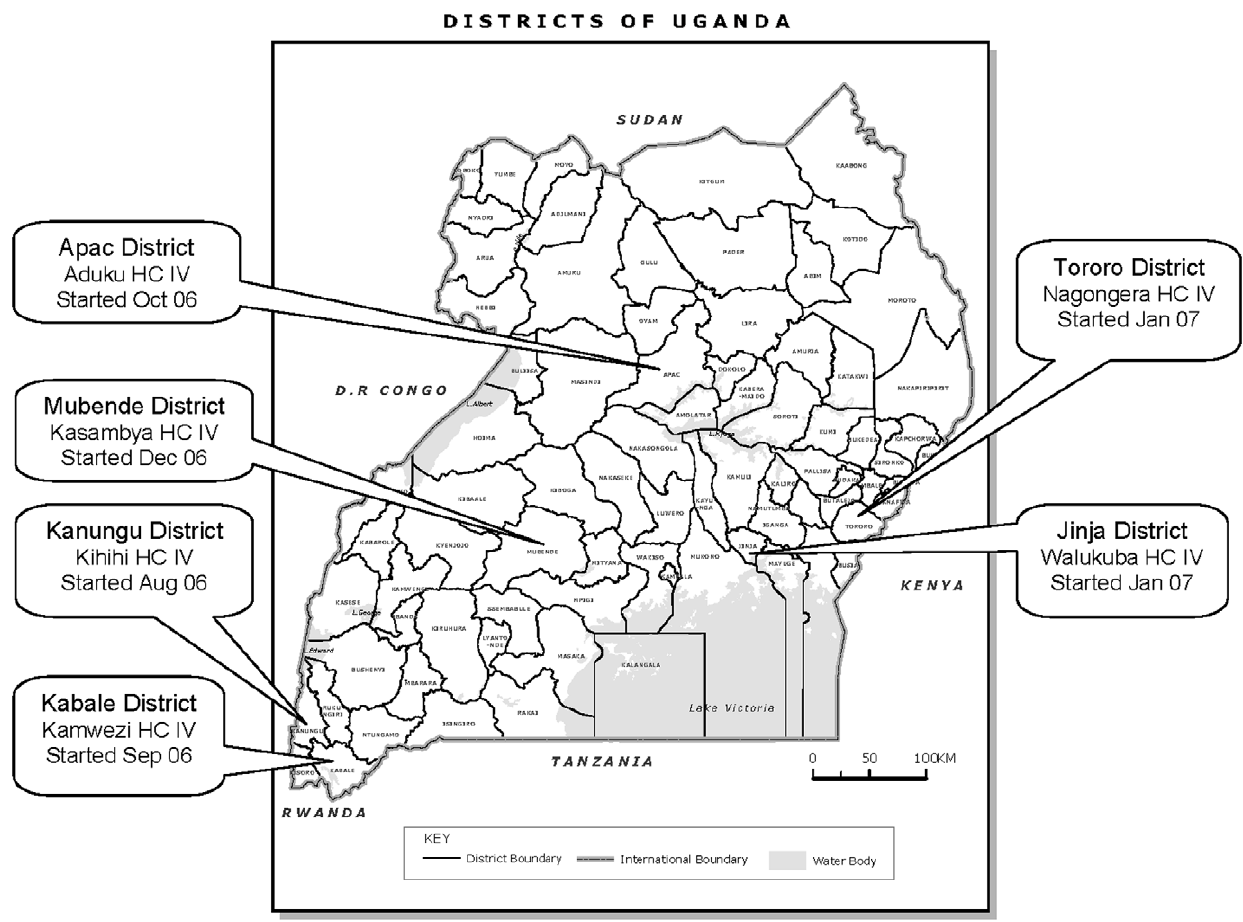
Figure 1. Map of the districts, government health centers, and dates of initiation for the UMSP sentinel sites.